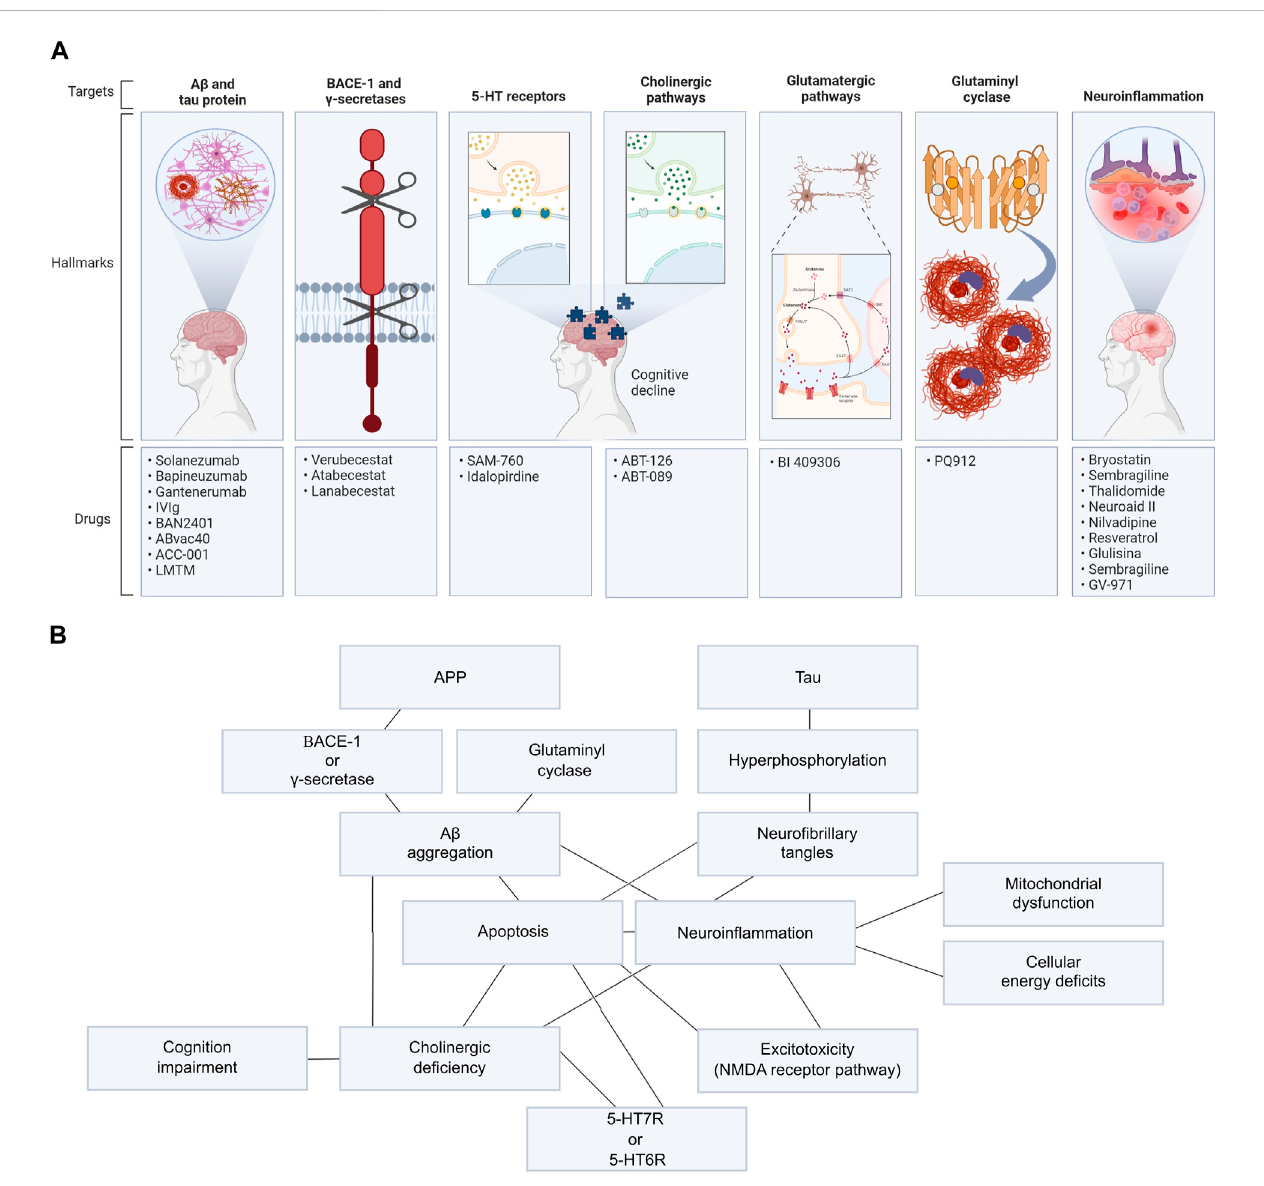
FIGURE 1 MainpotentialtargetsfordrugdesigninADandrelationofitspathways. (A) AD ’ stargetsusedtodevelopnewdrugsinclinicaltrialsevaluatedinthiswork. (B) All mechanisms related to AD pathogenesis and progression are connected and were explored in these clinical trials, such as A β and tau aggregation; BACE-1, γ -secretase, or glutaminyl cyclase activity; neuroin fl ammation; excitotoxicity; 5-HT7R or 5-HT6R hyperstimulation and cholinergic